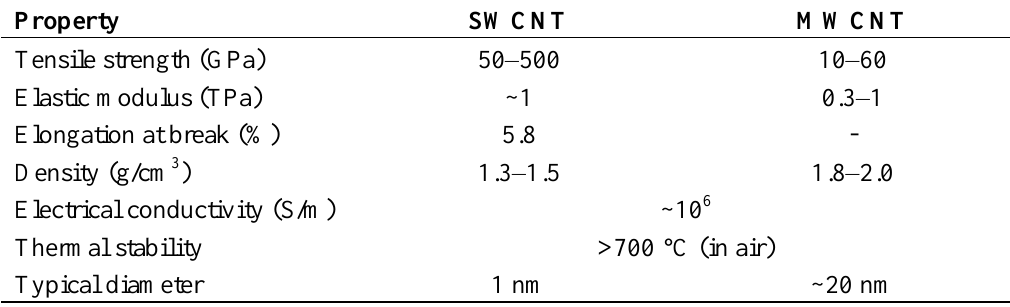
Table 1. Typical properties of carbon nanotubes (CNTs)